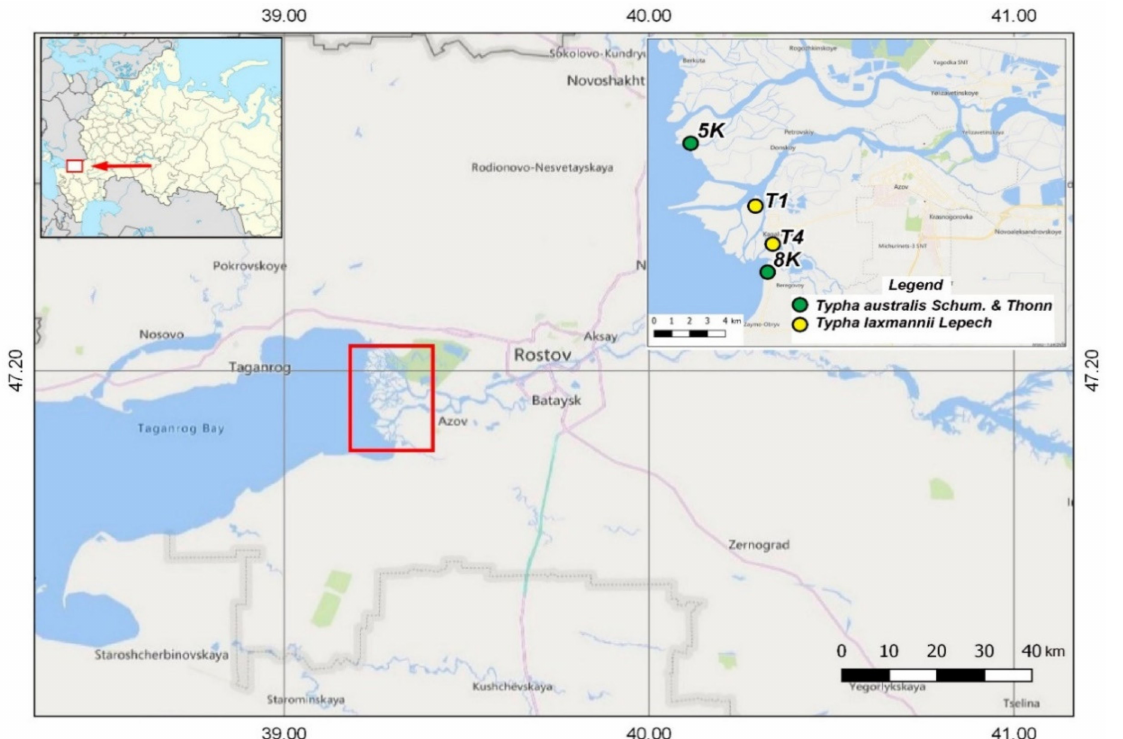
Figure 1. The sea edge of the Don River delta, showing the sampling locations for soils and plants: background plots: 5K and T1, polluted plots: 8K and